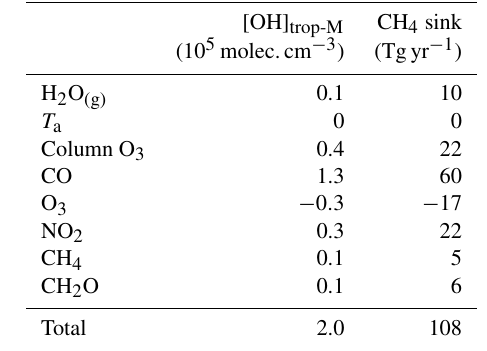
Table 4. Contributions from individual factors to the difference in global [OH] trop-M and tropospheric CH 4 sink by reaction with OH between CESM1–CAM4Chem simulated and the corresponding observation-based OH fields